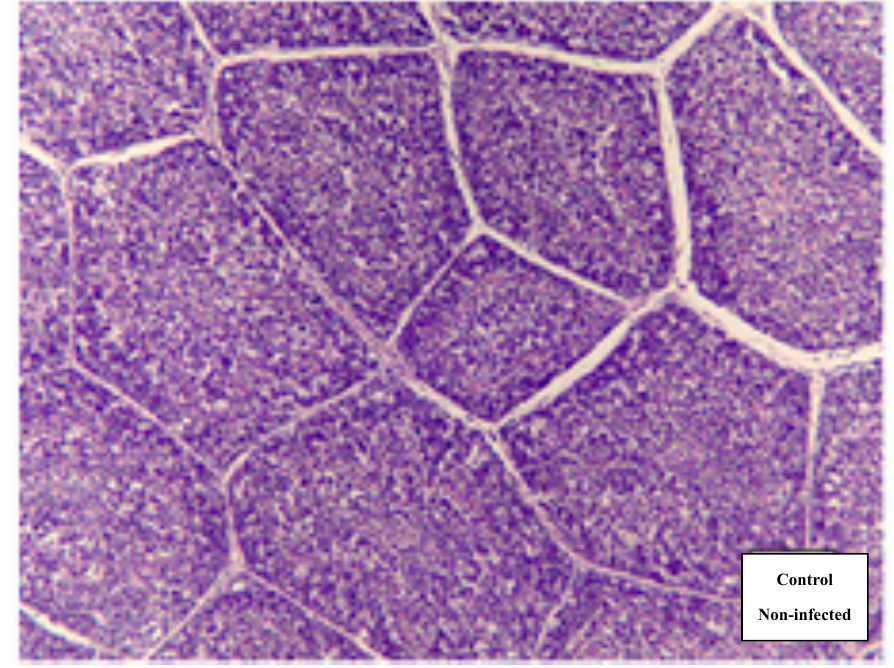
Figure 1. Normal bursal tissue section stained with hematoxylin and eosin (H&E) in the non-infected group.